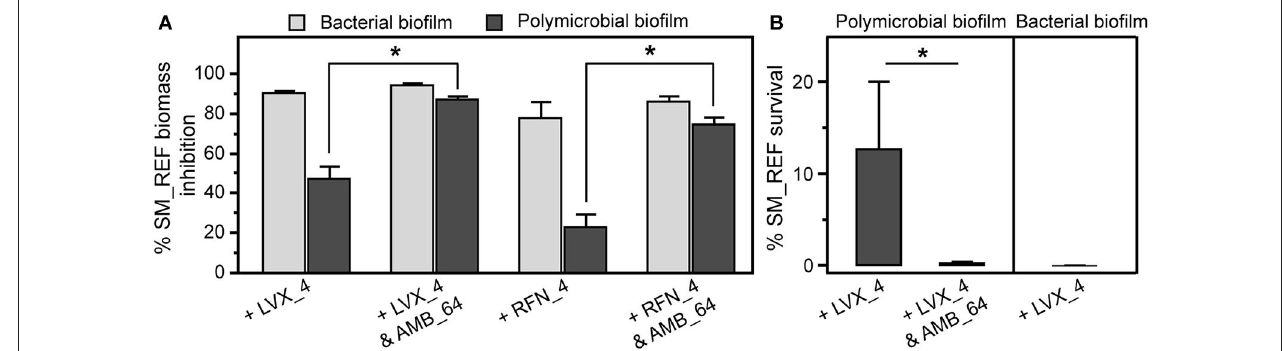
FIGURE 9 | Effects of antifungal-antibacterial combination on A. fumigatus-S. maltophilia biofilm. (A) Susceptibility of SM_REF in bacterial (light gray) and polymicrobial (dark gray) biofilms to LVX and RFN alone or in two-drug combination with AMB assessed by qPCR. (B) Percentages of SM_REF survival following LVX alone or in two-drug combination with AMB treatment in bacterial and polymicrobial biofilms using viable plate count. * p < 0.05; AMB_64, amphotericin B (64 µ g/mL); LVX_4, levofloxacin (4 µ g/mL); RFN_4, rifampicin (4 µ g/mL).